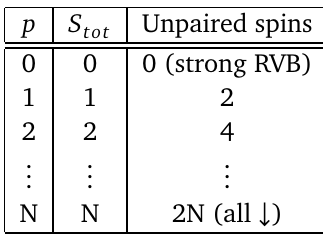
Table 1: Collapse by photon detection for M = N . The columns show p (the number of photons detected), the S sector onto which collapse occurs, and the number of unpaired spins in the tot resulting RVB